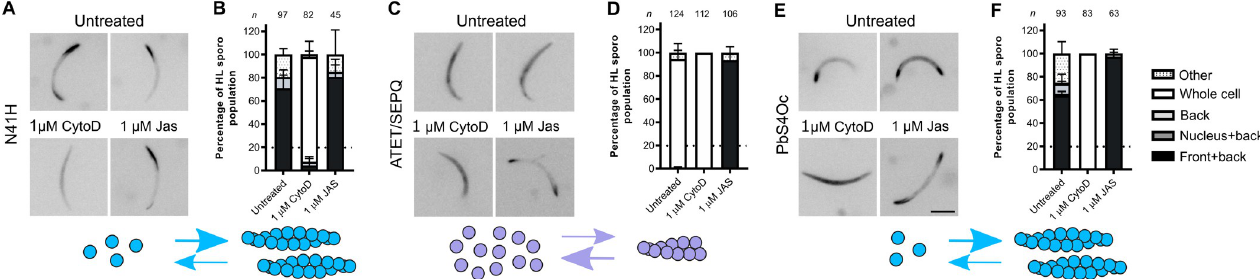
Fig 6. Actin mutations result in different consequences for hemolymph sporozoite actin localization. (A) Representative images of chromobody localisation for subdomain 2 mutant N41H untreated and with actin modulators cytochalasin D (CytoD) and jasplakinolide (Jas). (B) Quantifications of localisations in the attached and motile populations. The untreated N41H parasites resemble Jas treated cells indicating a potentially increased filament pool and increased filament stability. (C) Representative images of chromobody localisation for subdomain 3 mutant ATET/SEPQ untreated and with actin modulators. (D) Quantifications of localisations in the attached population (no motile sporozoites were observed since the mutations have a pronounced effect on hemolymph sporozoite motility). The untreated ATET/SEPQ parasites resemble CytoD treated cells indicating a potentially negative effect on the filament pool and filament stability. (E) Representative images of chromobody localisation for subdomain 4 mutant PbS4Oc untreated and with actin modulators CytoD and Jas. (F) Quantifications of localisations in the attached and motile populations. The untreated parasites resemble Jas treated cells indicating a potentially increased filament pool and increased filament stability. Scale bar: 5 μ m. Dotted lines indicate relative percentage of “Front + back” localization for the wild-type control as quantified in Fig 5. Bars represented as mean ± standard deviation across independent assays. Cartoons underneath represent possible shifts in actin monomer and filament amounts based on changes of chromobody